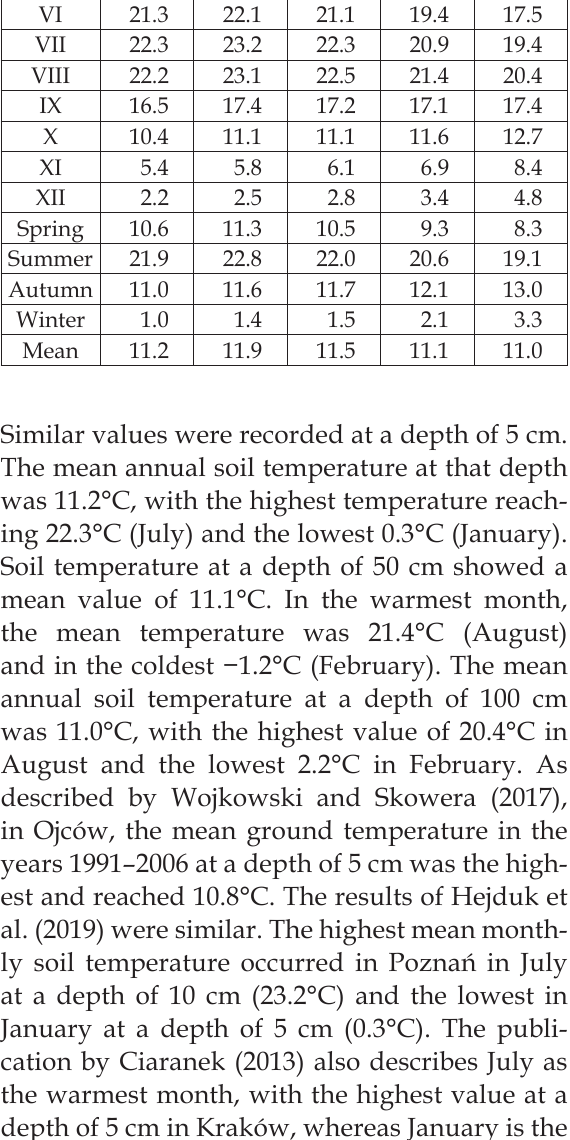
Fig. 2. Annual distribution of soil temperature